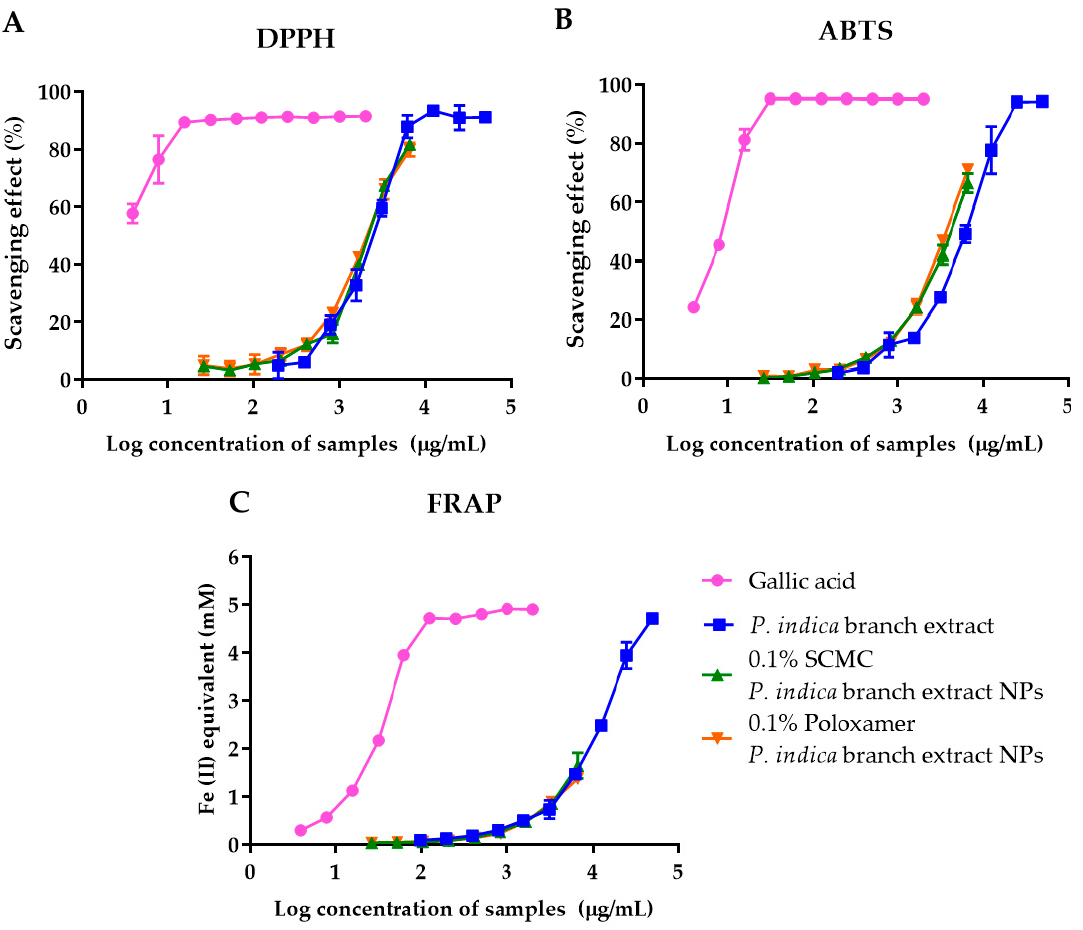
Figure 3. The antioxidant activity of gallic acid, P. indica branch extract, 0.1% SCMC P. indica branch extract NPs, and 0.1% poloxamer P. indica branch extract NPs determined by ( A ) DPPH free radical scavenging assay ( B ) ABTS free radical scavenging assay and ( C ) FRAP assay. The data represent mean ± SD of three experiments.